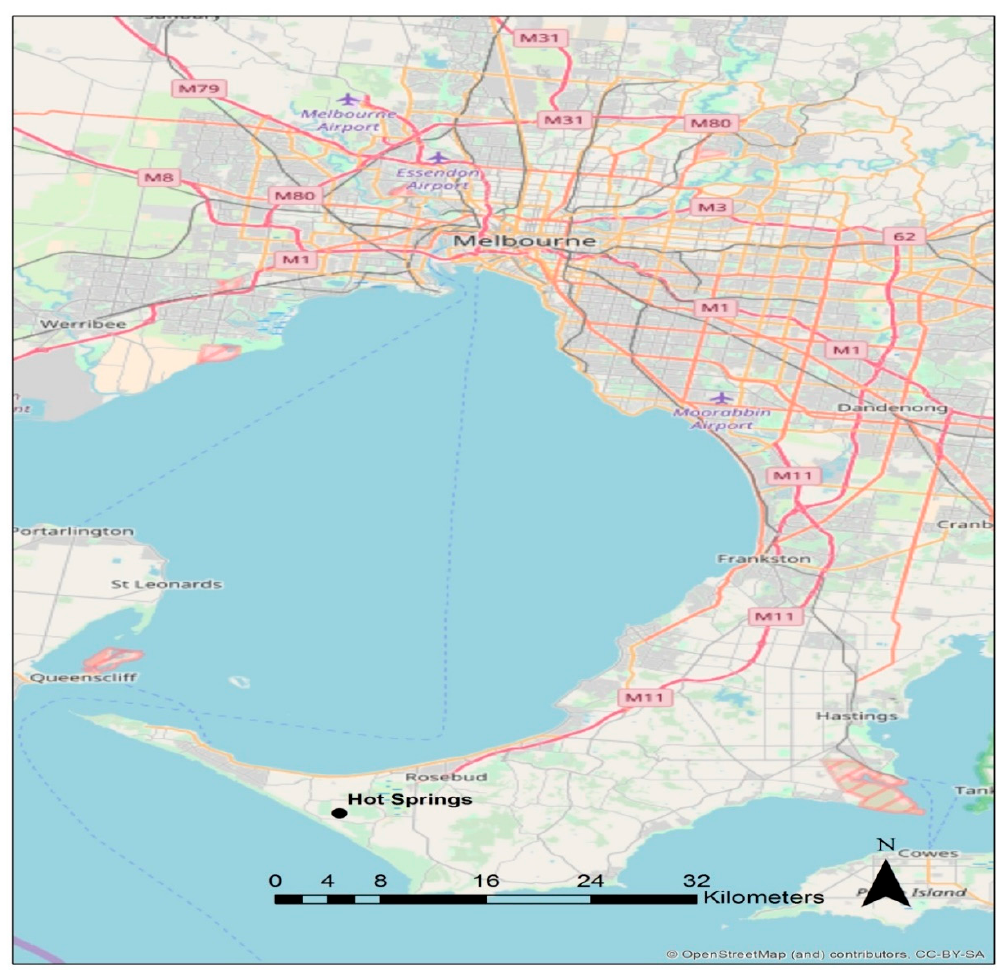
Figure 1. Location of the sampling site in Victoria, Australia, Coordinates: 38°24 ′ 32 ″ S, 144°50 ′ 12 ″ E.